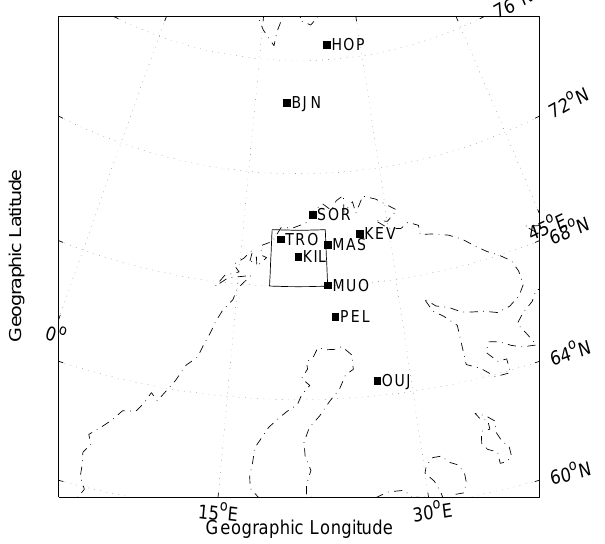
Fig. 1. The locations of the instruments used in this study. IMAGE magnetometers are indicated by the squares. The box centred on station KIL represents the IRIS field-of-view as used for the images in this paper.